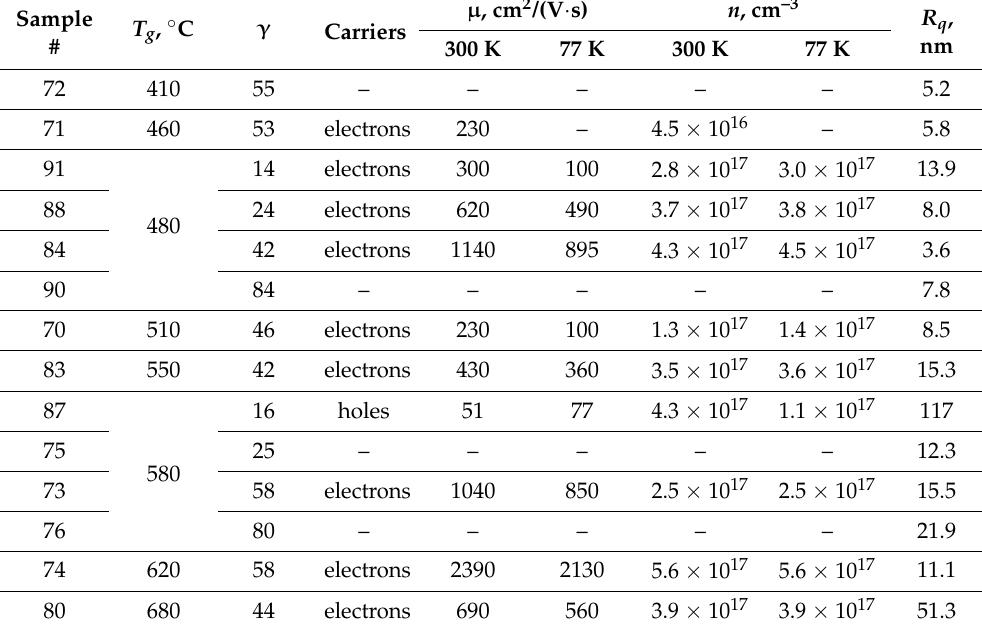
Table 1. Growth conditions (growth temperature T g , and As 4 /Ga flux ratio γ ) and properties of Si-doped GaAs (110) films (electron or hole conductivity, carrier mobility µ , and concentration n , root mean square surface roughness R q